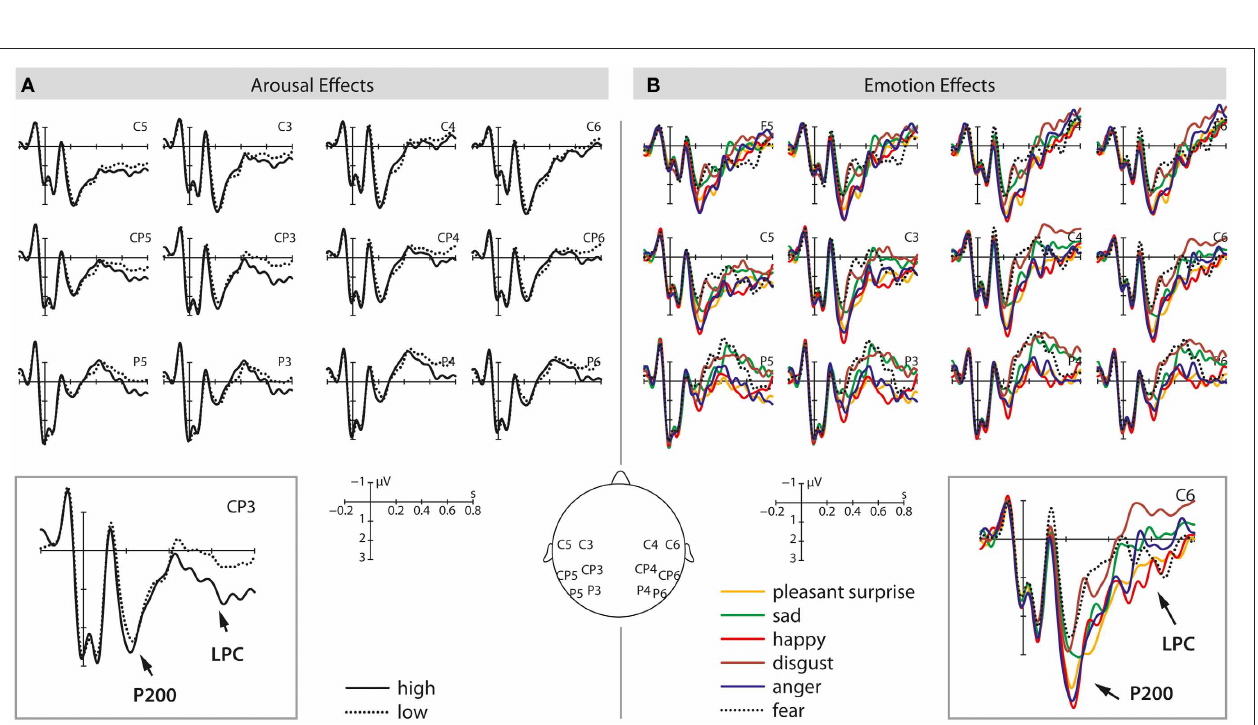
FIGURE 3 | This illustration shows the P200 and LPC effects at selected electrodes for high/low arousing stimuli (A) and the six different emotional categories tested (B). The left panel shows average waveforms for high (solid) and low (dotted) arousing stimuli from 200ms